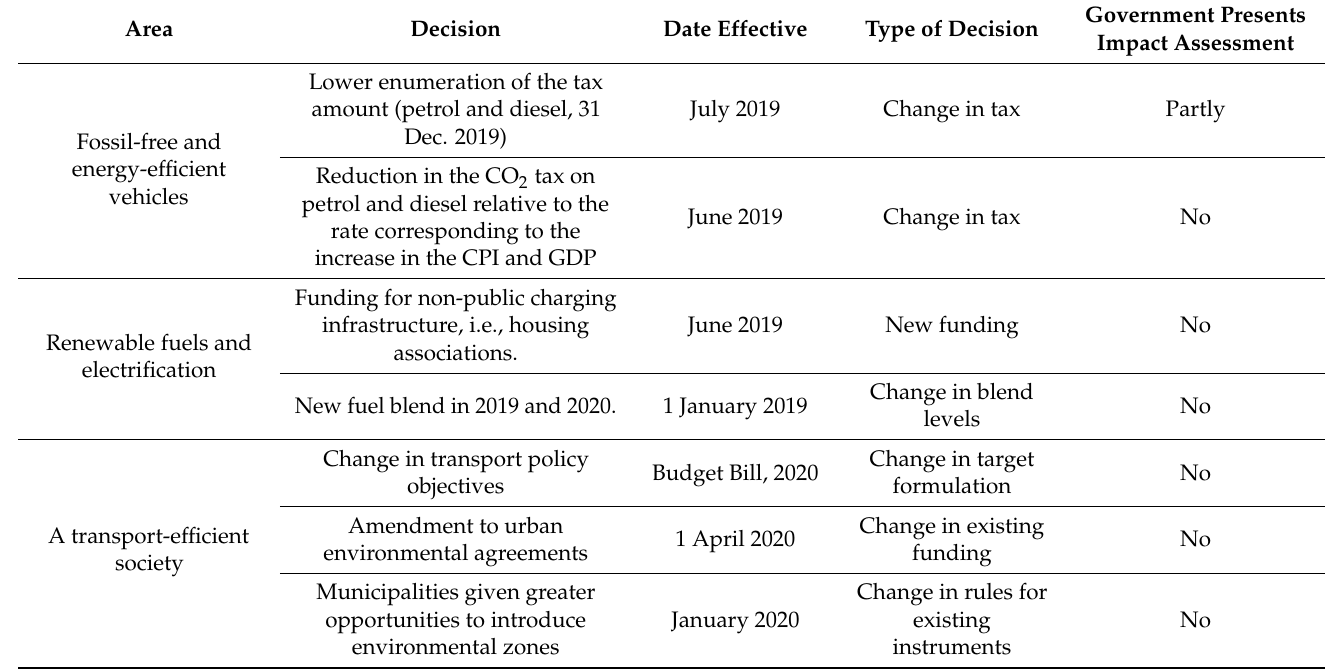
Table 10. Domestic transport and decisions taken in 2019 (Climate Policy Council, 2020)